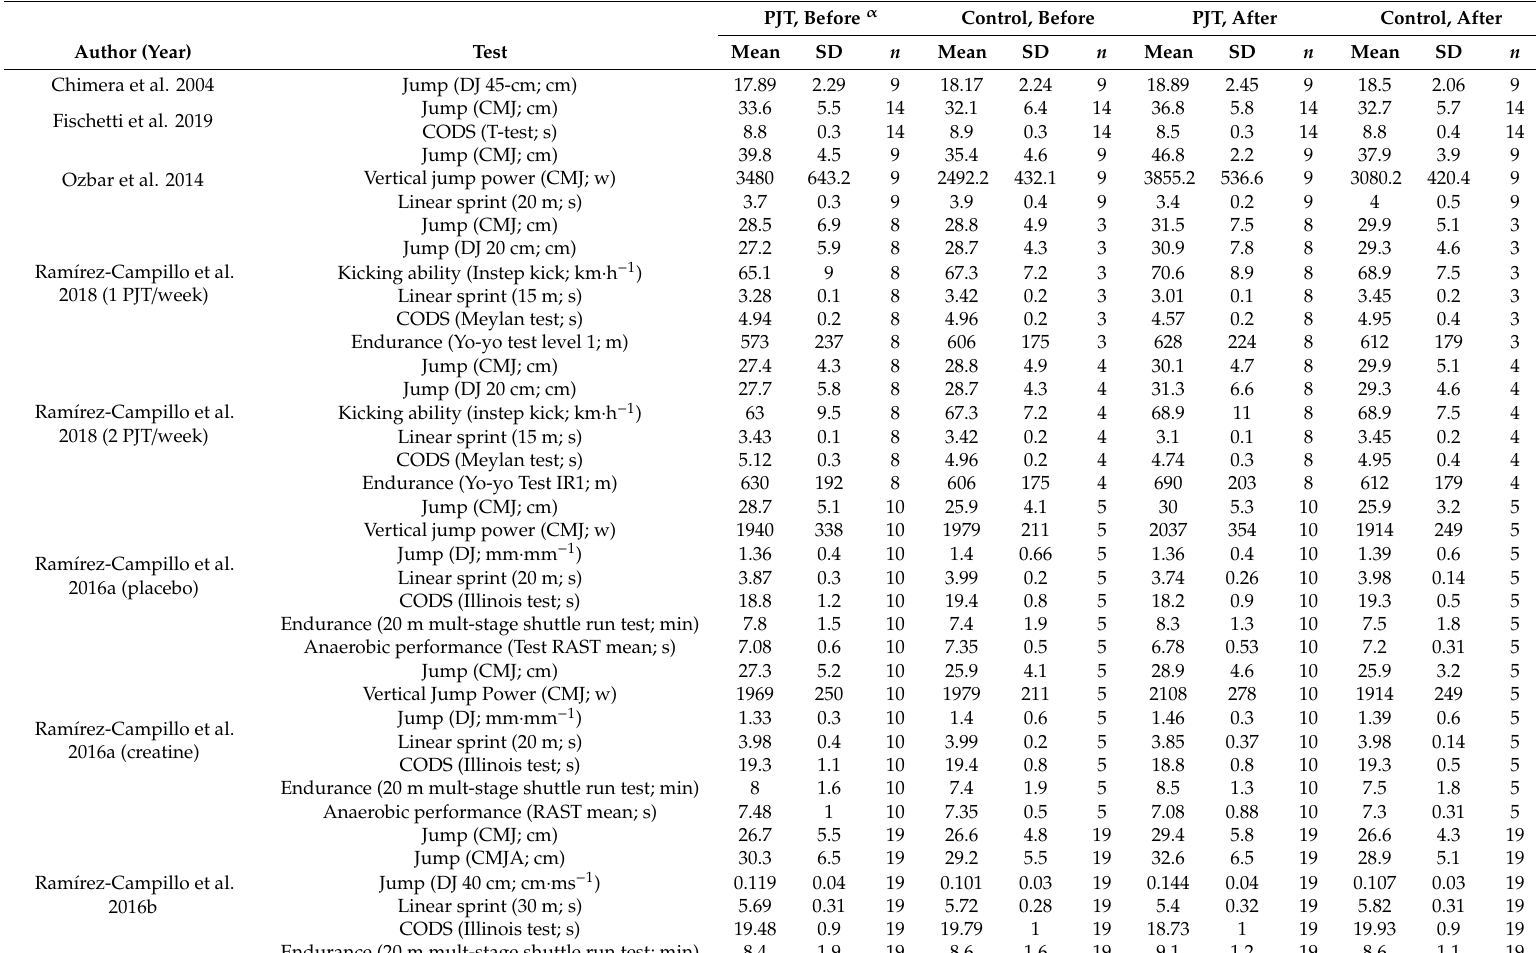
Table 3. Study groups and their physical